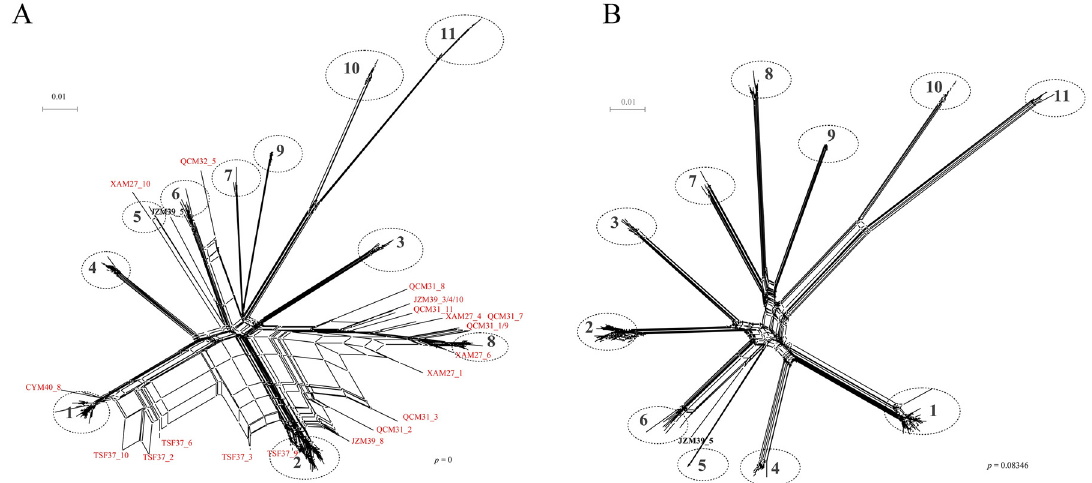
Fig 1. Phylogenetic networks of HPgV E1-E2 segments. ( A ) A split network, including all sequences, was first constructed. The sequences clustered in eleven clades designated 1 to 11. The outliers are classified as putative intra- subtype recombinants (in red) or a novel clade (in black). ( B ) Sequences inferring conflicting phylogenetic signals were excluded (recombinant candidates) were removed, and a new split network was